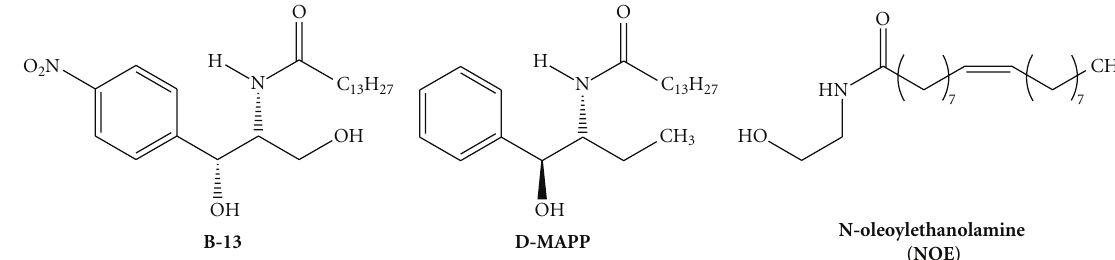
Figure 1: Current lead structures for the development of CDase inhibitors.